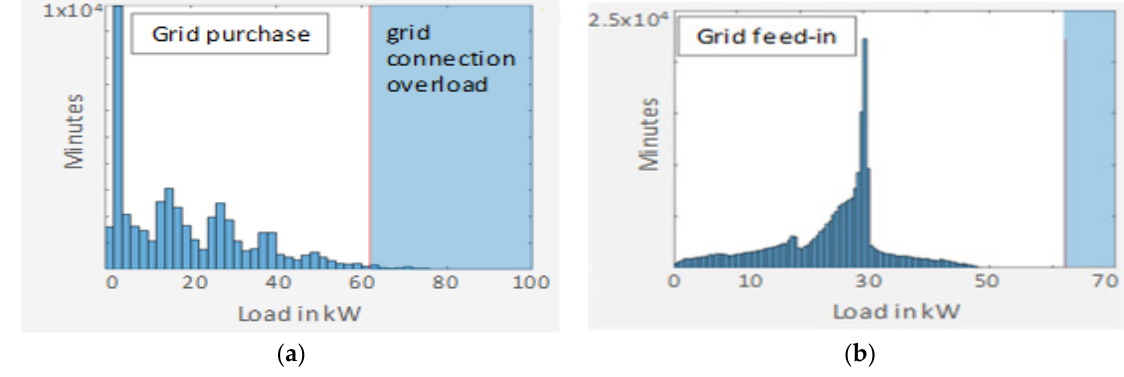
Figure 6. Time allocation for the electricity purchase from the public grid ( a ) and the feed-in to the public grid ( b ) in the simulation year. The necessary grid purchase with maximum 96 kW cannot be realised with the available grid connection.